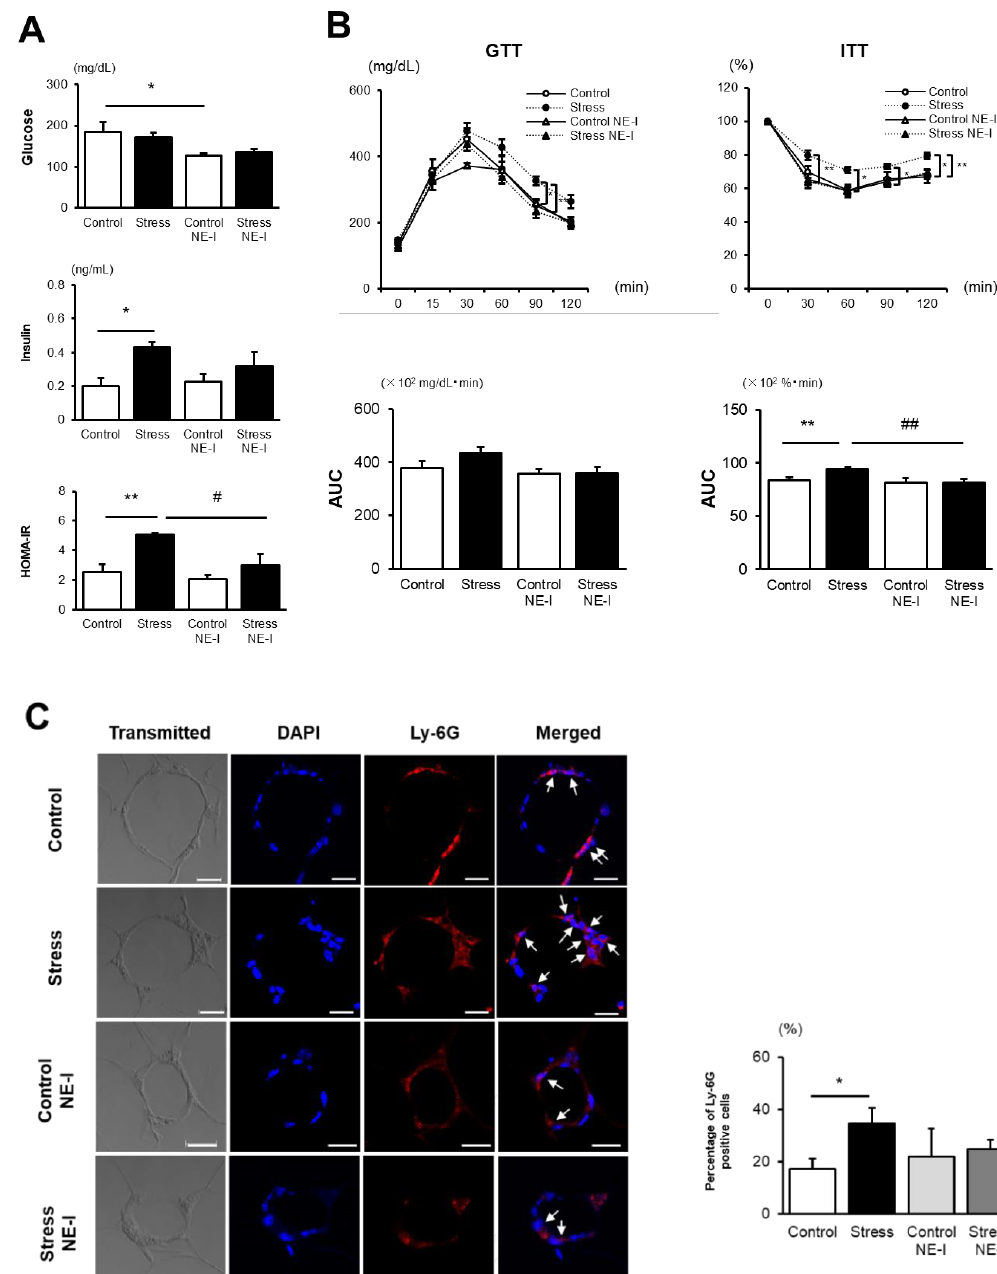
Figure 4 . NE inhibitor treatment diminishes the accelerated IR development in stressed mice. ( A ) Serum concentrations of fasting blood glucose and insulin as well as HOMA-IR after 6 weeks of HFD. Values represent the mean ± SEM for four (Control), five (Stress), four (Control NE-I), and four (Stress NE-I) mice. * p < 0.05 and ** p < 0.01 vs. Control. # p < 0.05 vs. Stress. ( B ) Glucose and insulin tolerance tests after 6 weeks of HFD. Values represent the mean ± SEM for four (Control), five (Stress), four (Control NE-I), and four (Stress NE-I) mice. GTT, glucose tolerance test; ITT, insulin tolerance test, AUC, area under the curve. ** p < 0.01 vs. Control. ## p < 0.01 vs. Stress. ( C ) Immunohistochemical staining of Ly-6G-positive cells and the percentages of Ly-6G-positive cells in CLSs of eWAT. Values represent the mean ± SEM for four (Control), five (Stress), four (Control NE-I), and four (Stress NE-I) mice. * p < 0.05 vs. Control. Arrow indicates Ly-6G-positive cells. Scale bar = 20 µm. Control, unstressed control mice; Stress, stressed mice; Control NE-I, NE inhibitor-treated unstressed control mice; Stress NE-I, NE inhibitor treated stressed mice.